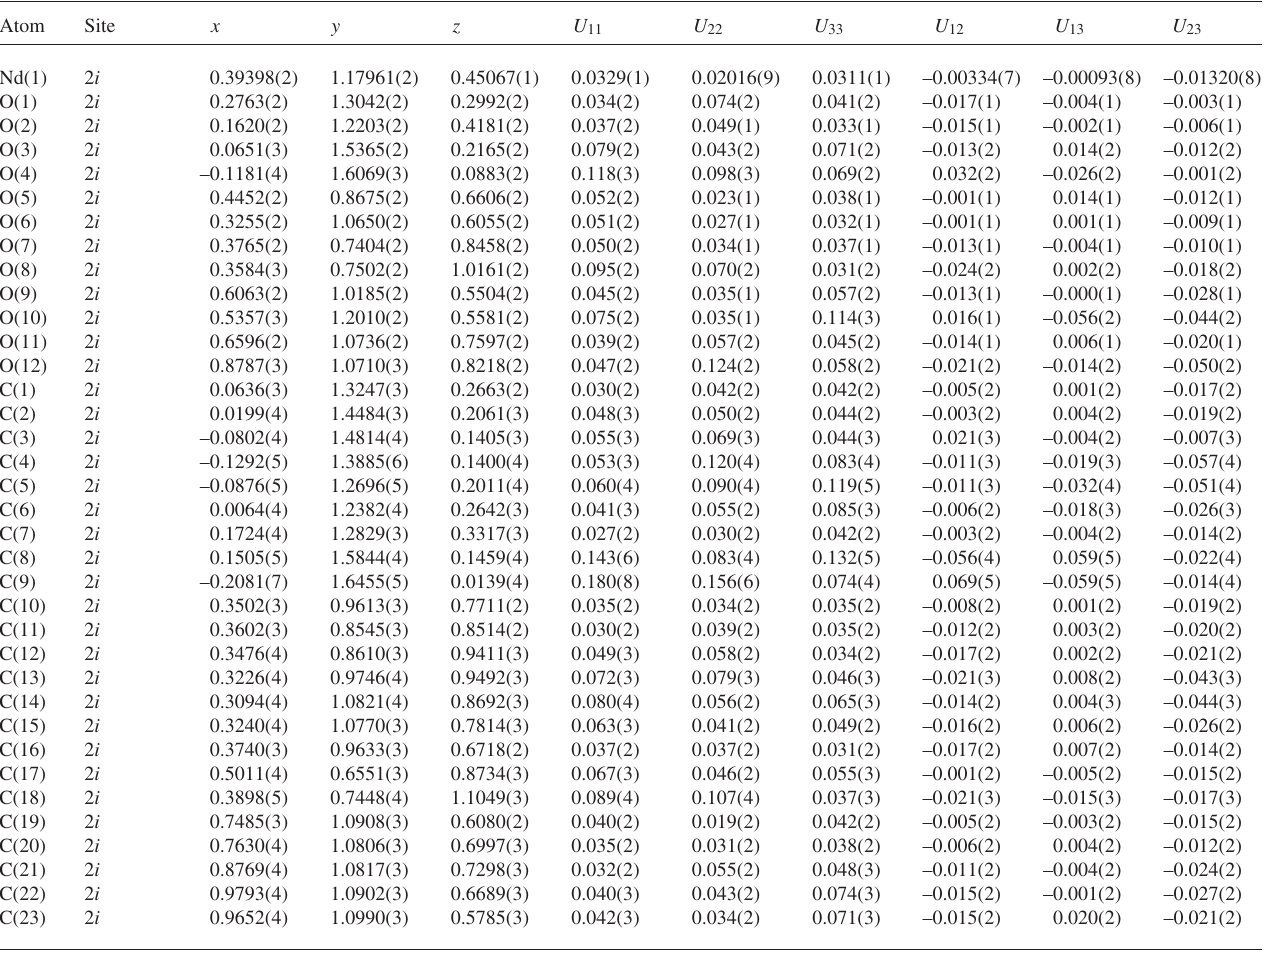
Table 3. Atomic coordinates and displacement parameters (in Å 2 ) .